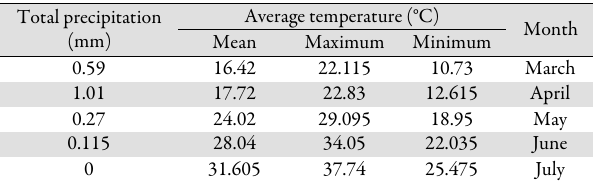
Table 1. Monthly temperature and precipitation during the growing season 2012